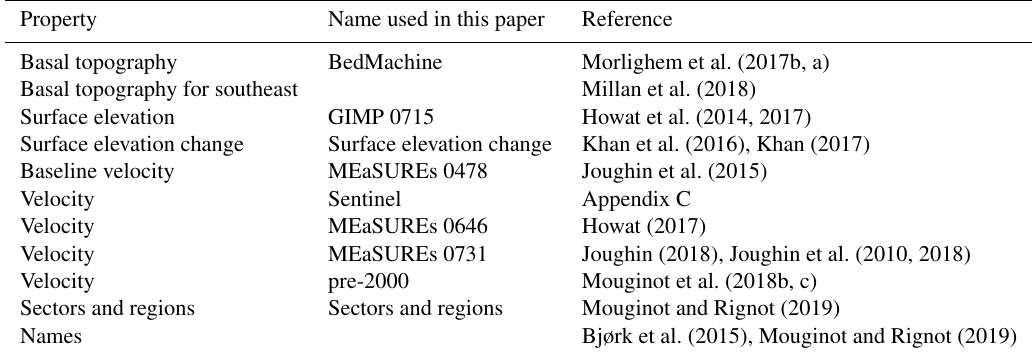
Table 1. Summary of data sources used in this